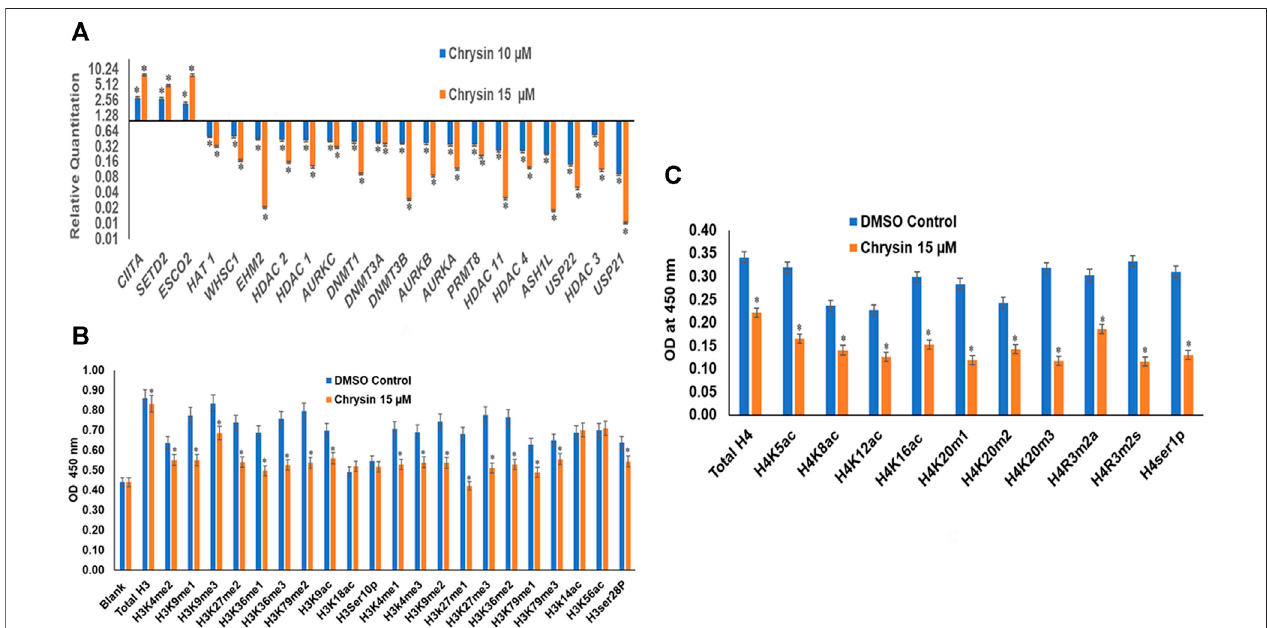
FIGURE5|(A) TreatmentofHeLacellswithchrysinat10and15 µMfor48 hmodulatedtheexpressionofepigeneticenzymes(HDACs,DNMTs,HATs,HMTs etc .) in a dose-dependent manner. (B) Chrysin modulates the H3 acetylation and methylation histone marks at 15 – 48 h. (C) H4 histone marks modulated by chrysin as compared to the DMSO controls.